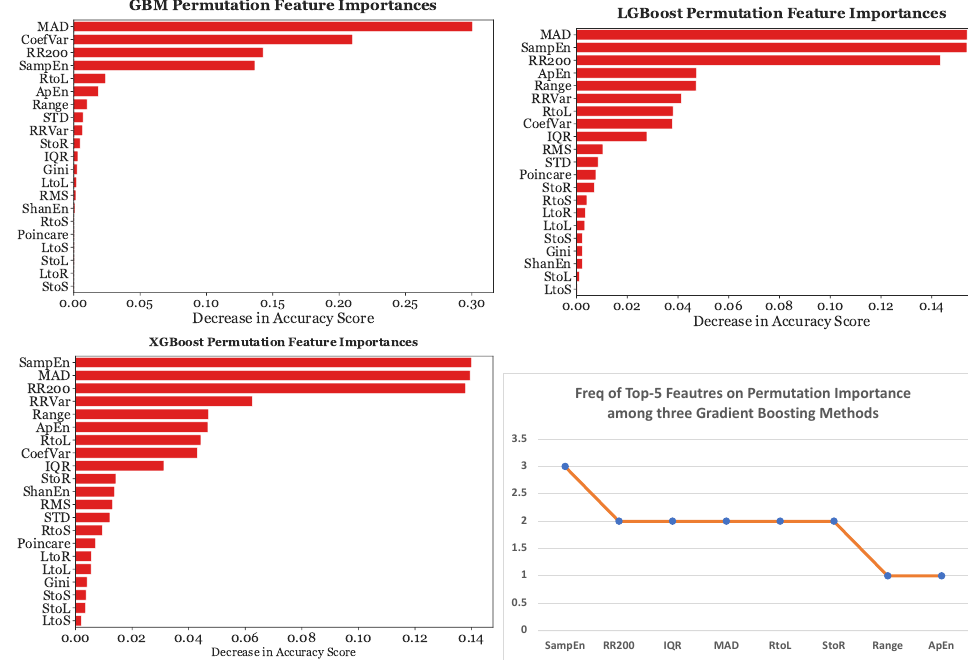
Figure 15. Permutation importances for gradient boosting models with the 25-s segmentation scheme.